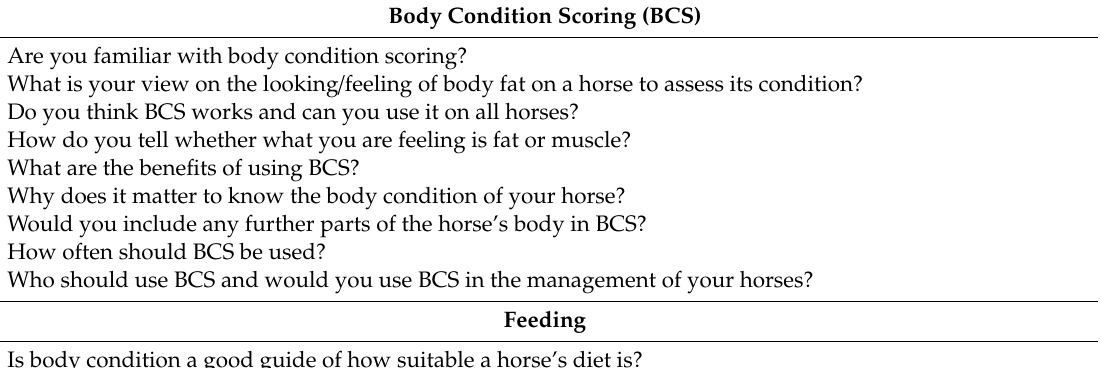
Table 1. Questions used in the interviews and discussion groups. Body Condition Scoring